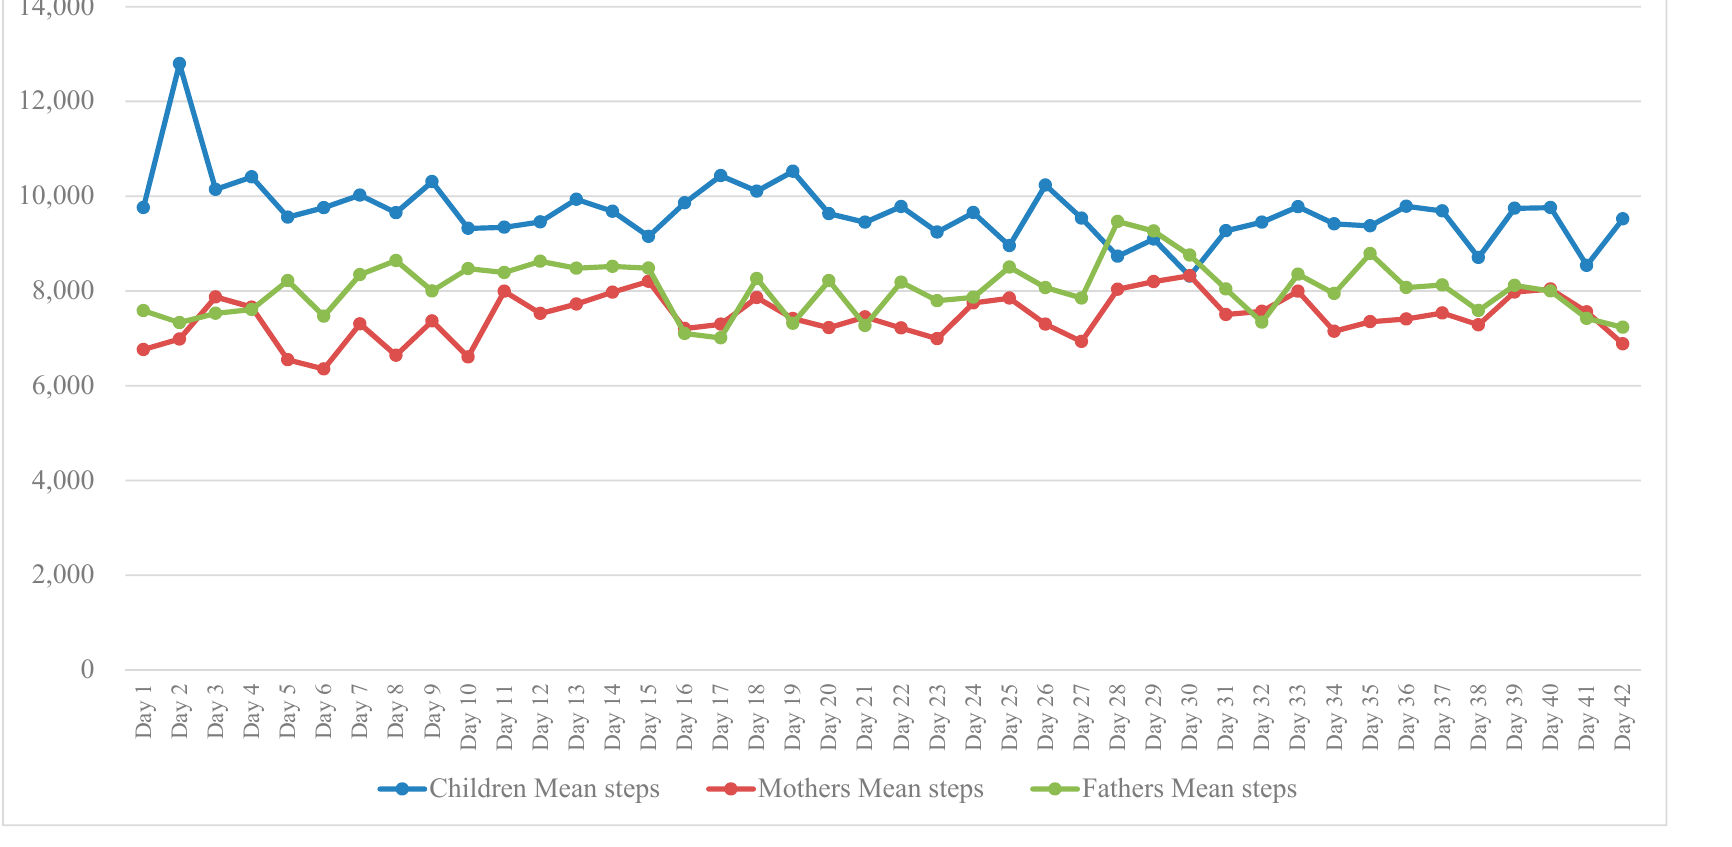
Figure 2. Mean steps per day in children, mothers and fathers during the 6-week (42-day) intervention.